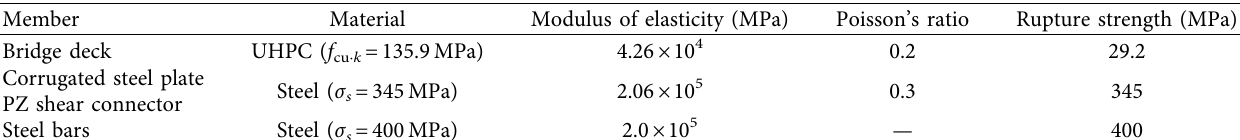
Figure 4: Details of corrugated steel plate-UHPC composite bridge deck with PZ shear connectors (unit: mm). (a) Cross section of corrugated steel plate-UHPC composite bridge deck. (b) PZ shear connectors. Table 1: Material properties of composite bridge deck.